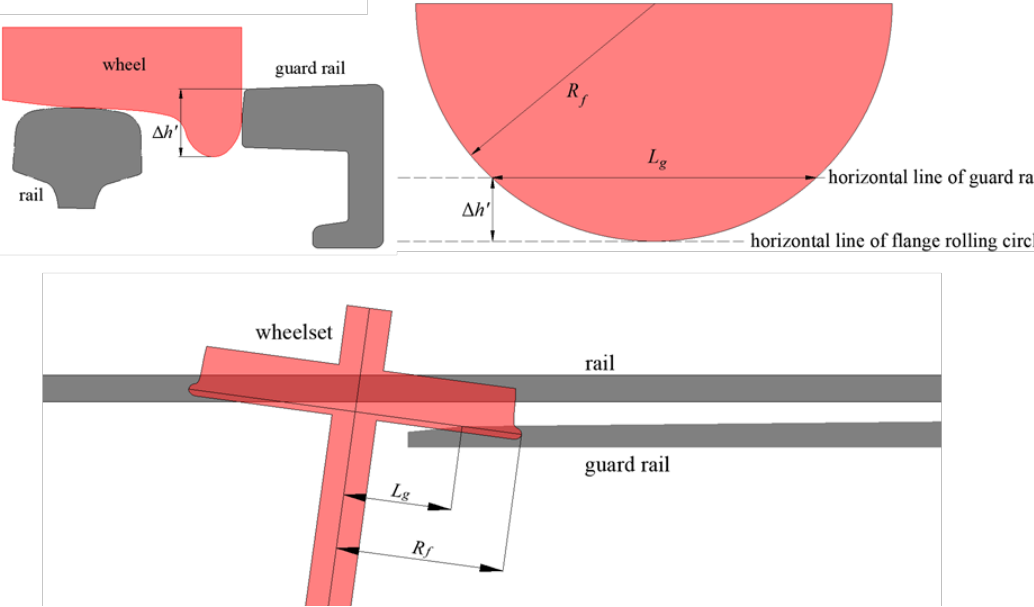
Figure 7. Relationship between the height difference between the top of the wheel flange to the top surface of the guardrail ' h and the flange hitting the guardrail.